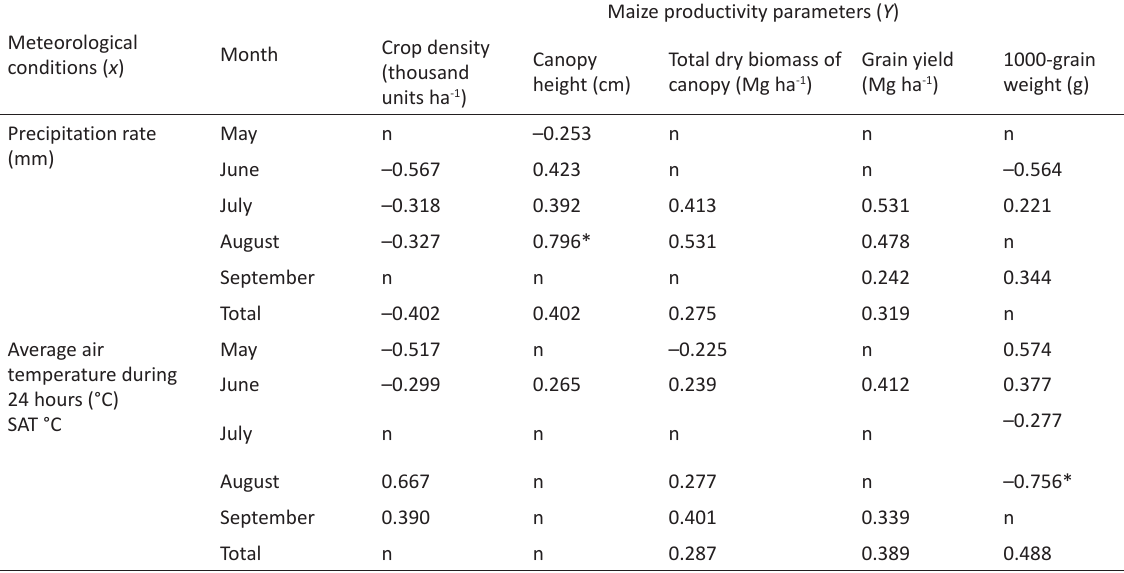
Table 11. Correlation between meteorological conditions and maize productivity parameters in 2008–2015 Meteorological conditions ( x